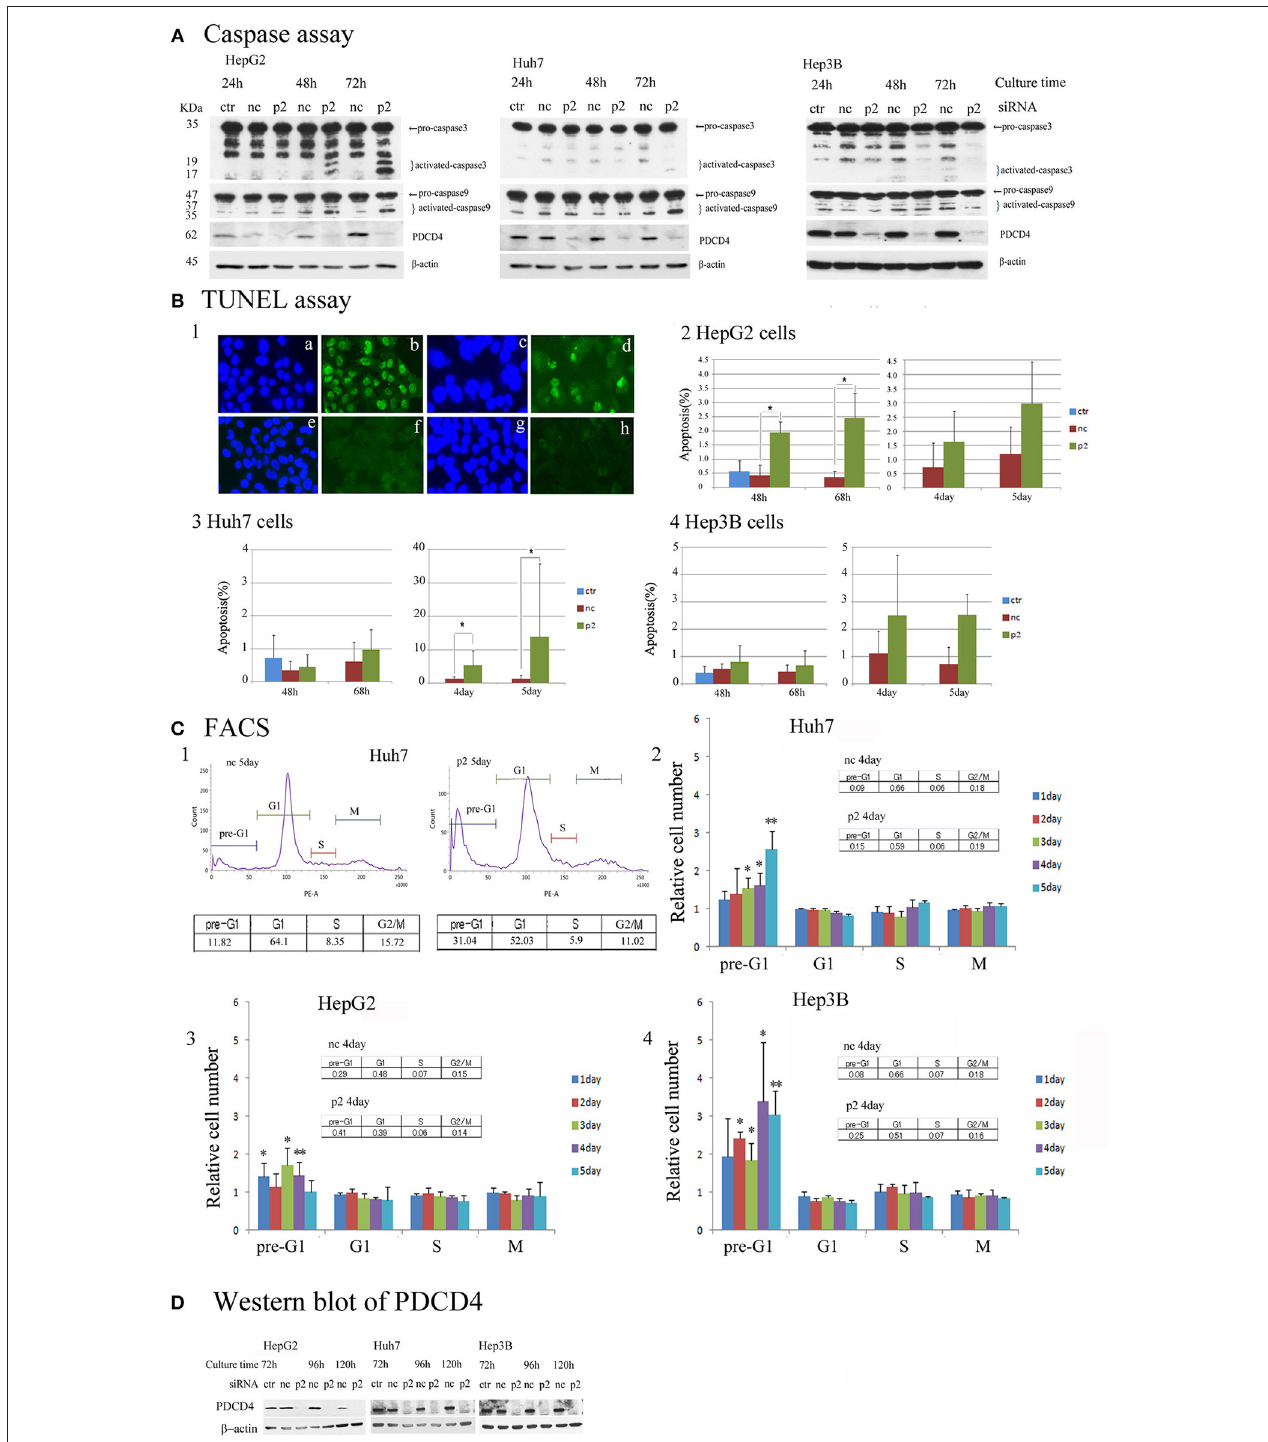
FIGURE 6 | Apoptosis induced by PDCD4 knockdown in HepG2, Huh7 and Hep3B hepatoma cells. (A) Caspase assays. The experiments were performed as in Figure 2 . An immunoblot analysis was performed with antibodies recognizing caspase 3 and caspase 9 for cell extracts of the untreated cells (ctr), negative control siRNA-treated cells (nc) and PDCD4 specific p2 siRNA-treated cells (p2) in HepG2, Huh7, and Hep3B cells. These experiments were repeated two times, and similar